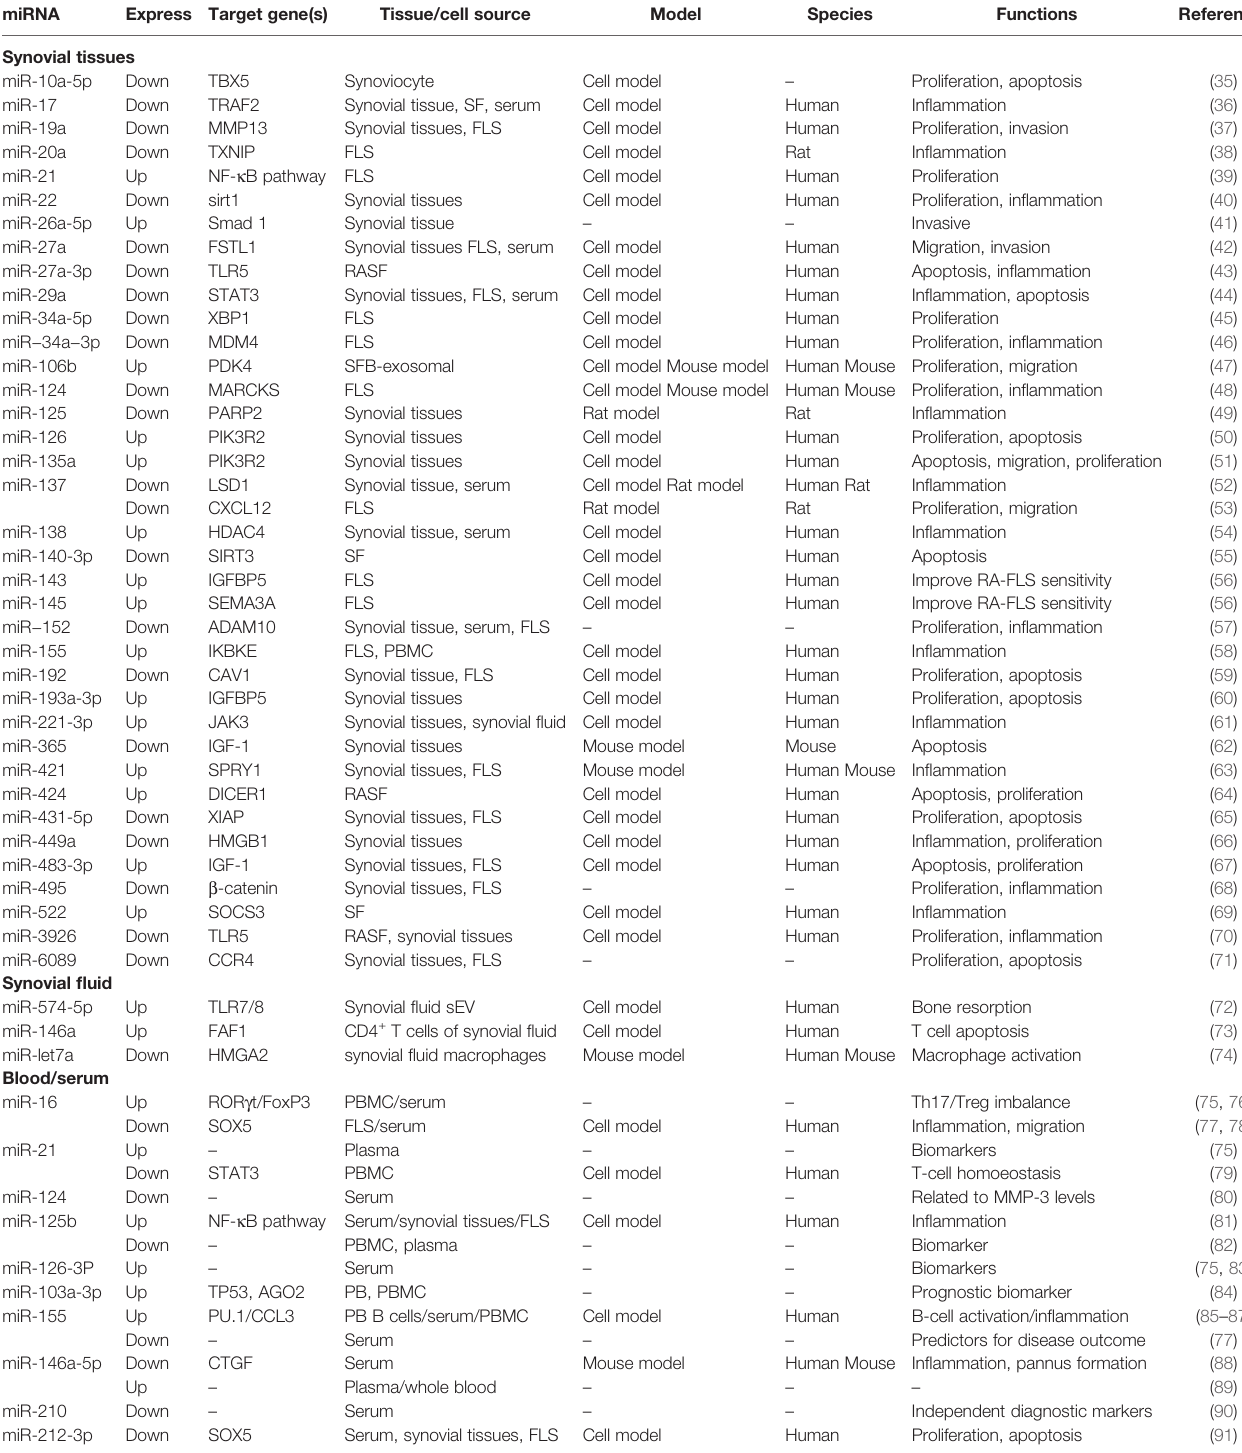
TABLE 1 | The aberrantly expressed miRNAs in RA.